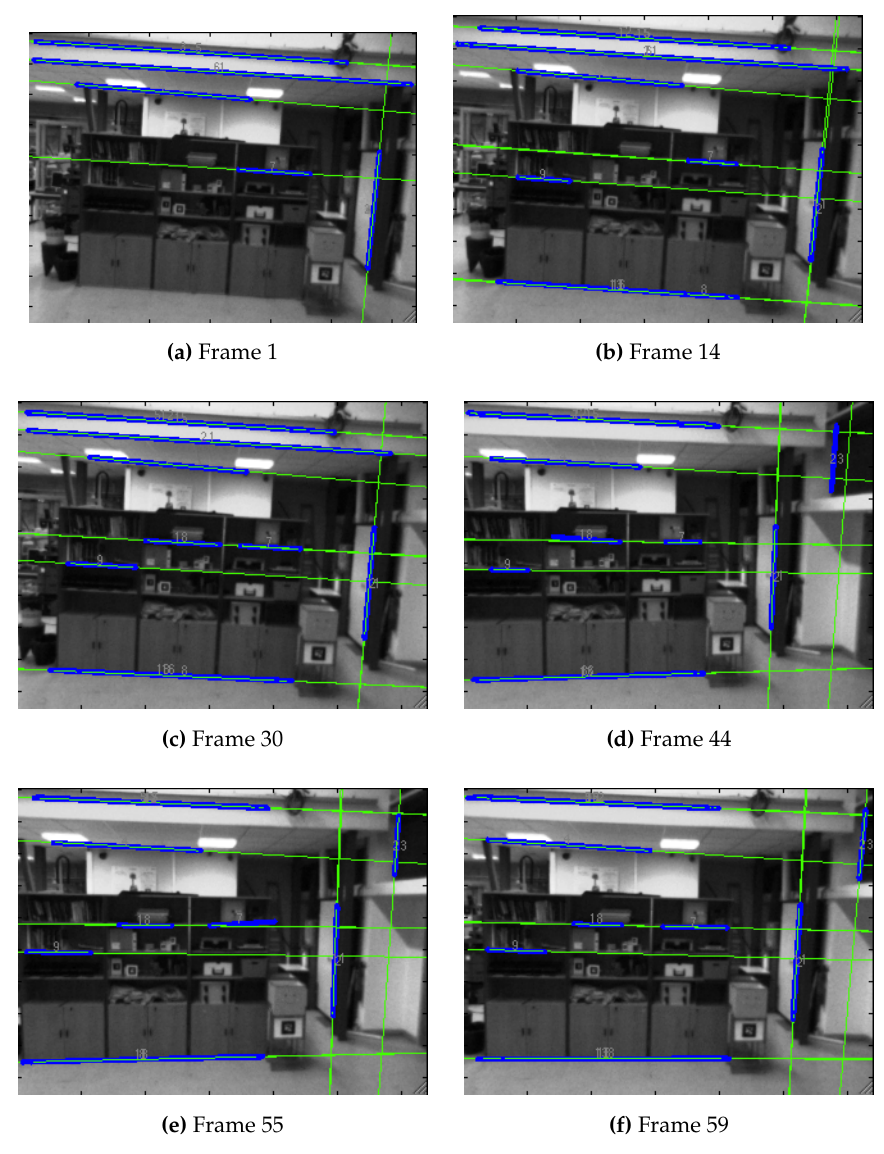
Figure 12. Front end operation of segment-based EKF-SLAM in an indoor sequence, showing the prediction and observation of landmarks. Infinite thin lines represent the estimated position of the landmark in the current image, while thicker segments show the match